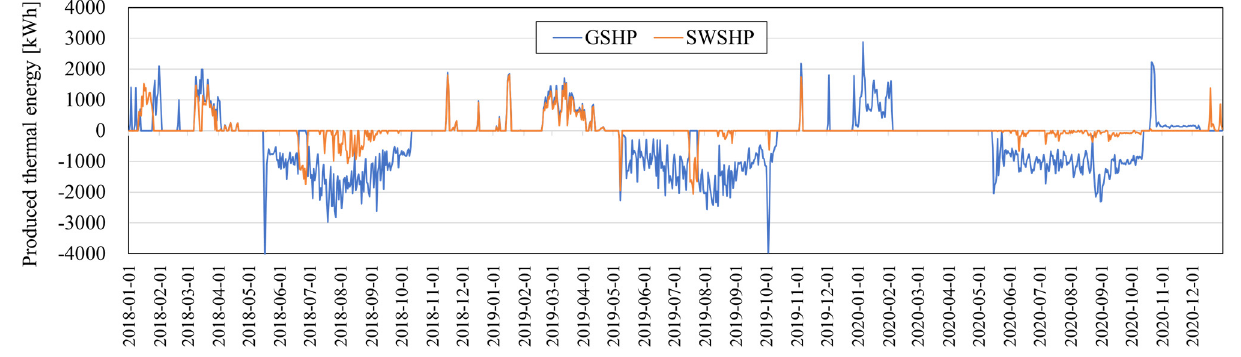
Figure 5. Daily thermal production rate of the heat pumps.